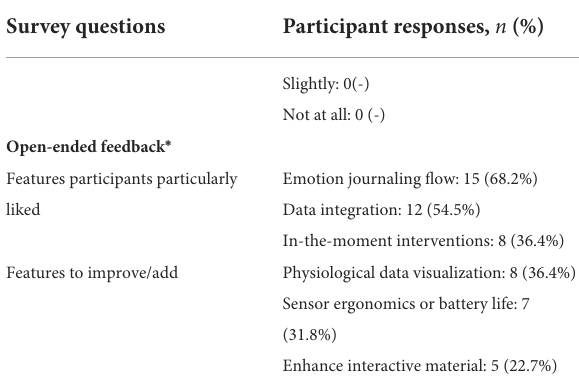
TABLE 3 Participant responses to the user feedback survey.